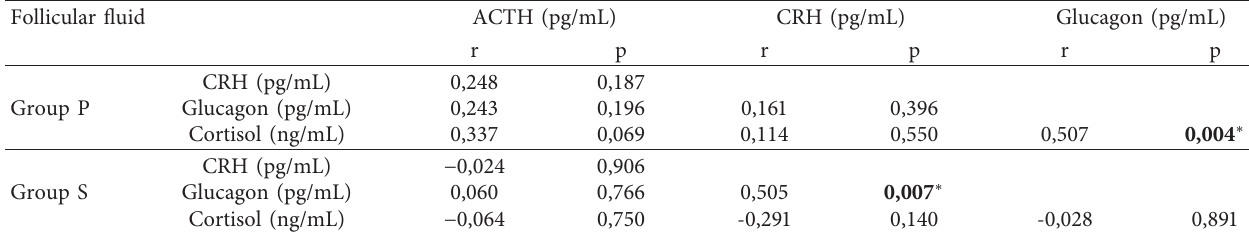
Table 6: Correlation analysis of postoperative follicular fluids between groups.